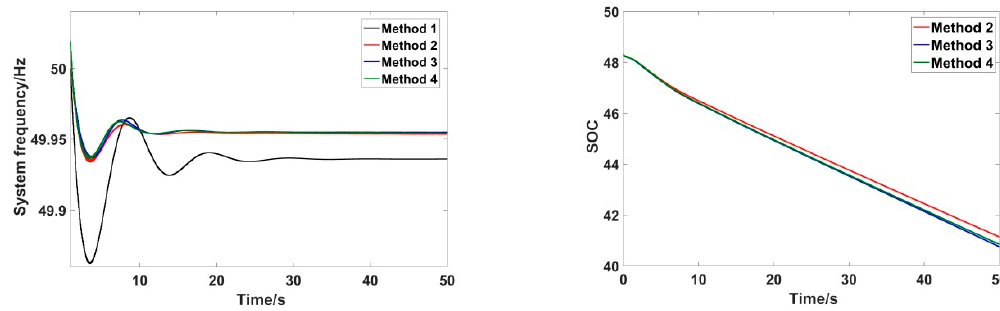
Figure 8. Results of 13 MW (megawatts) step load disturbance.